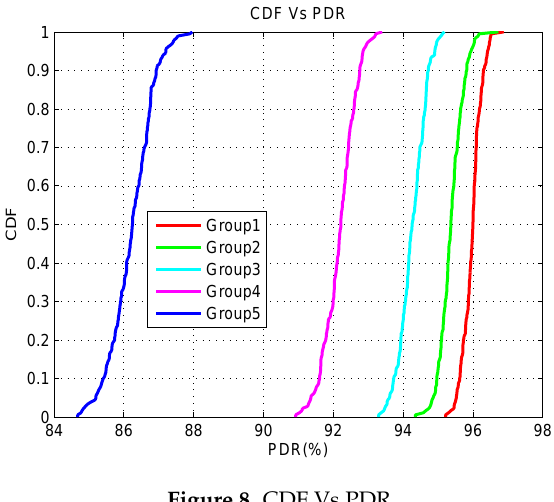
Figure 8. CDF Vs PDR.